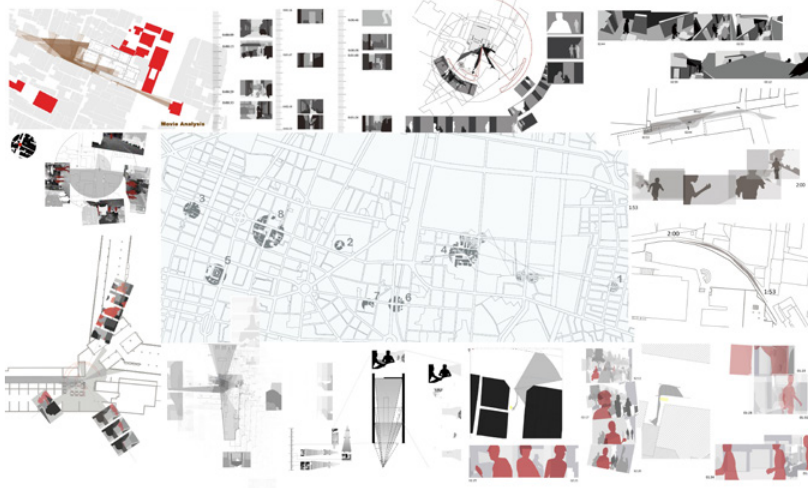
Figure 4. Student work from NCKU Cinemetrics Workshop,